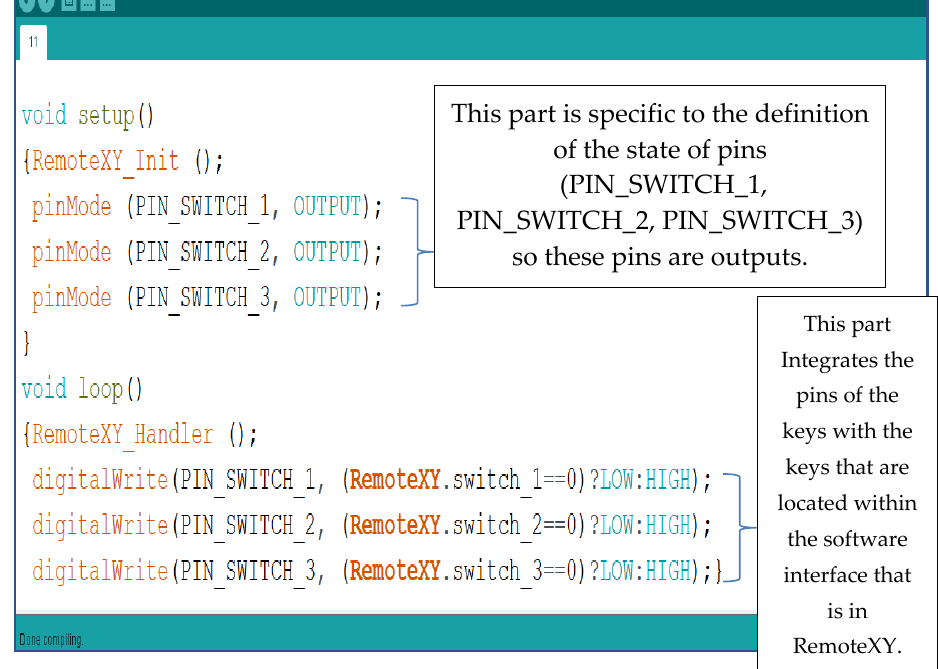
Figure A2. The second part of the executed code used to control lighting and sockets.